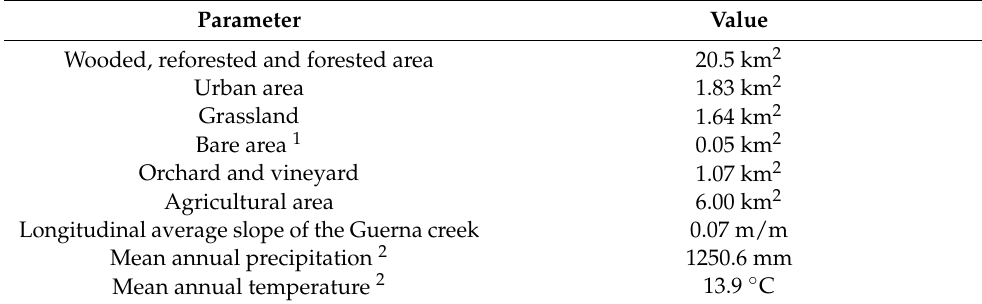
Figure 1. Guerna catchment site (North Italy). Source: Google Maps. Figure 2. Guerna catchment: ( a ) digital elevation model (DEM), ( b ) land use map [26]. Table 1. Characteristics of the Guerna creek catchment [27,26].